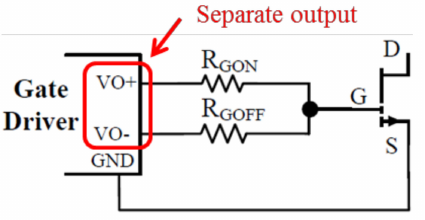
Figure 9. Gate driver with separate high and low outputs [31].